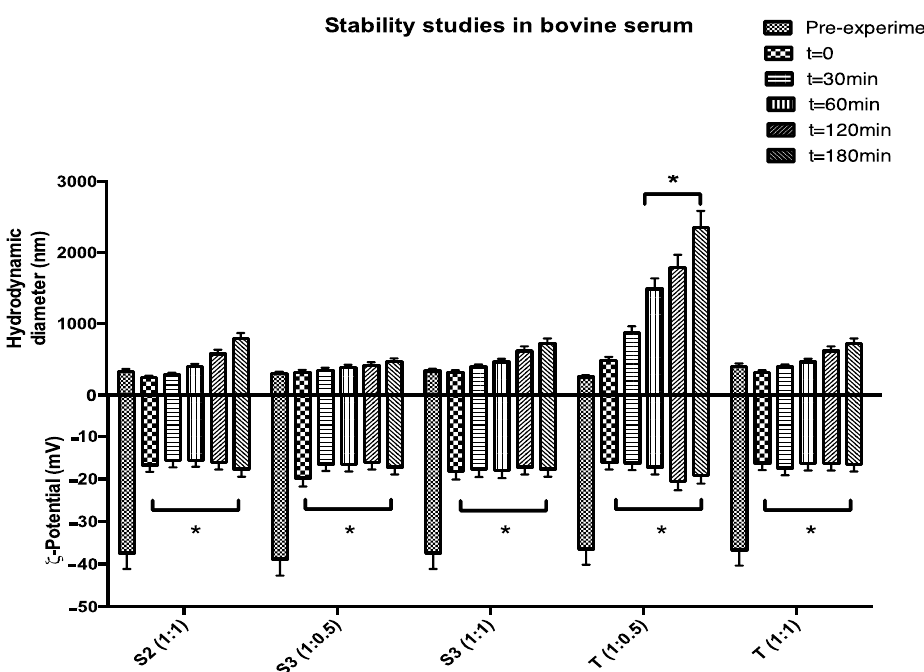
Figure 6. Biological stability studies in terms of hydrodynamic diameter and ζ-potential variations of HA-Chol-coated Span (S2 and S3) and Tween (T) niosomes up to 3 h at 37 °C (* p < 0.05).